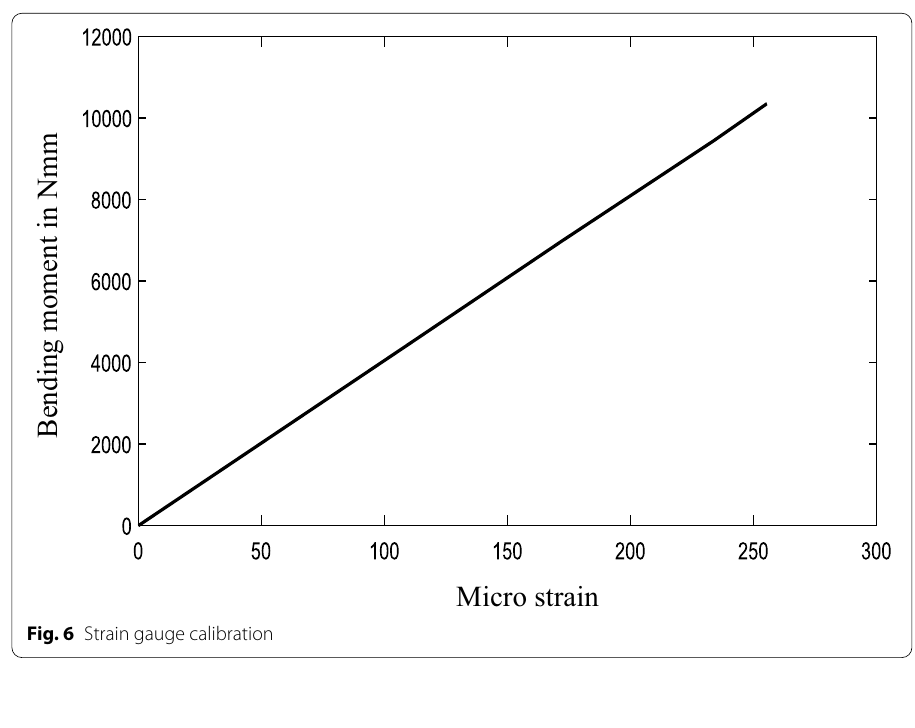
Fig. 6 Strain gauge